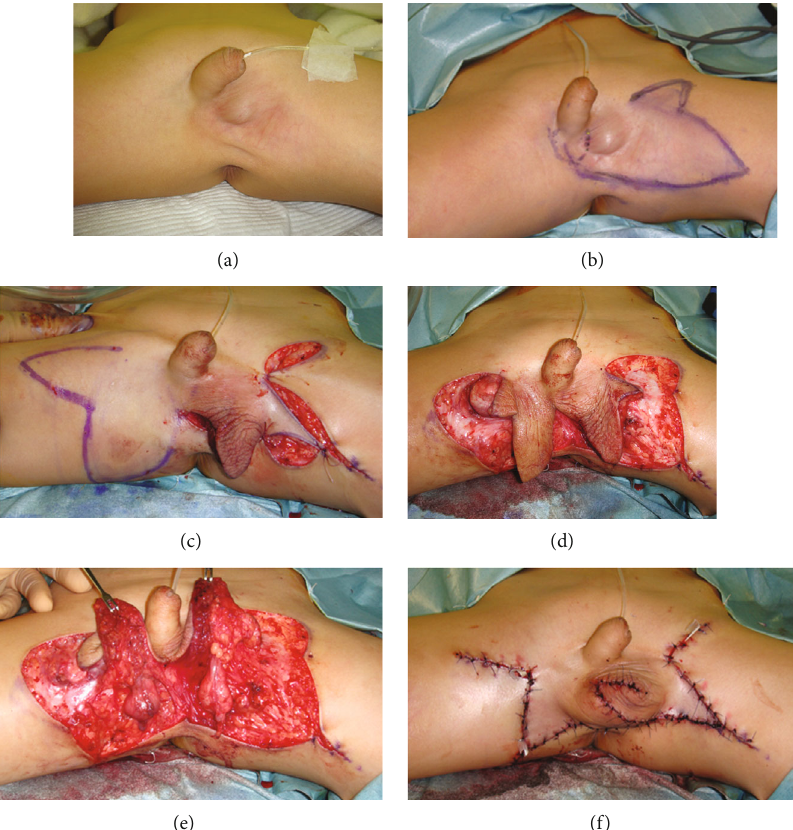
Figure 4: Case 2. (a) Presurgery. (b) Skin fl ap design of the left side. (c) Skin fl ap design of the right side. (d) Skin fl aps were elevated. (e) Testes are present. (f) Immediately